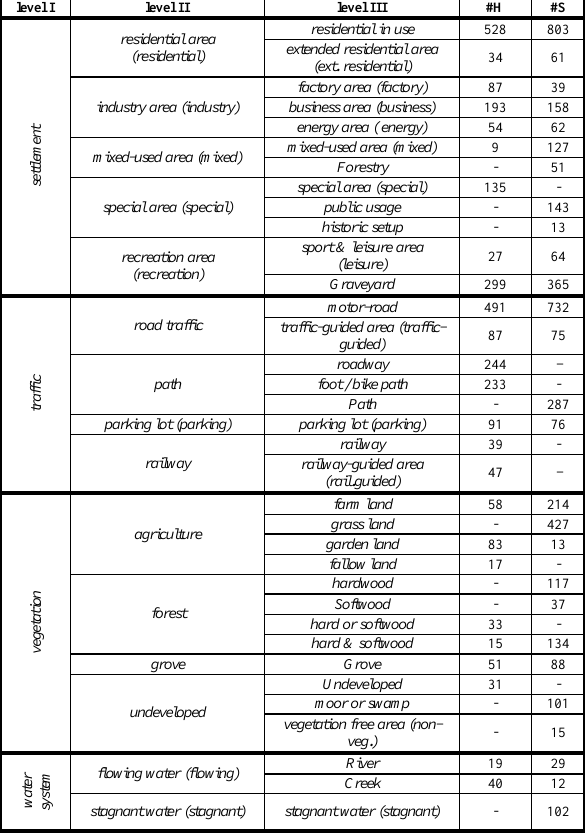
Table 1. Hierarchical class structure. Abbreviations are shown in brackets. #H / #S : number of samples in level III for Hameln and Schleswig, respectively. “-“ indicates that a class does not occur in the respective